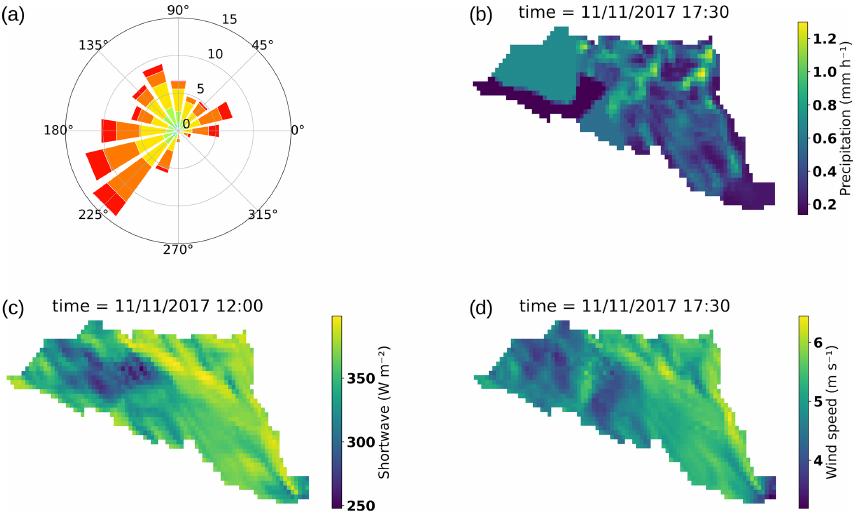
Figure 4. (a) Wind rose diagram. (b) Precipitation distribution along the catchment. (c) Shortwave radiation distribution over the catchment. (d) Wind speed distribution over the catchment. All are plotted for 11 November 2017 at 05:30pm and 12:00pm for shortwave